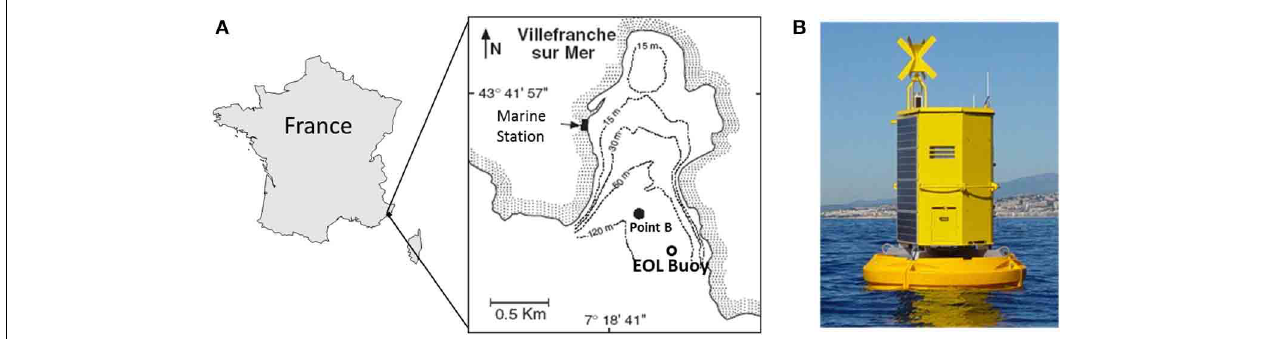
FIGURE 1 | (A) Location of the study site in the Bay of Villefranche-sur-Mer (northwestern Mediterranean Sea). Point B corresponds to the SOMLIT ( Service d’ObservationenMilieuLittoral )samplingpointwheresamplesarecollectedweekly. (B)